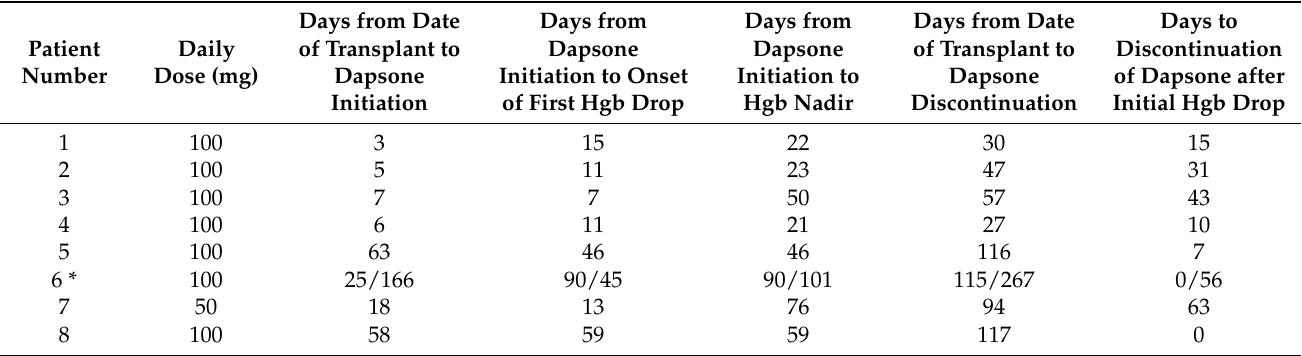
Table 3. Dapsone duration and recognition of